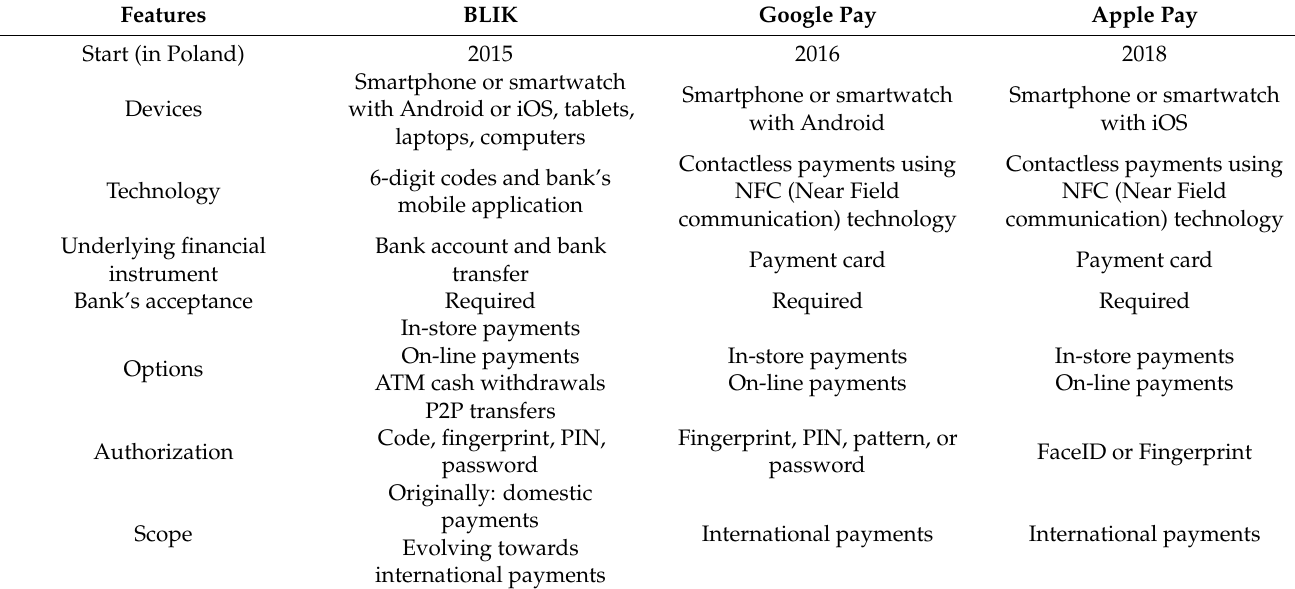
Table 7. Comparison: BLIK vs Google Pay and Apple